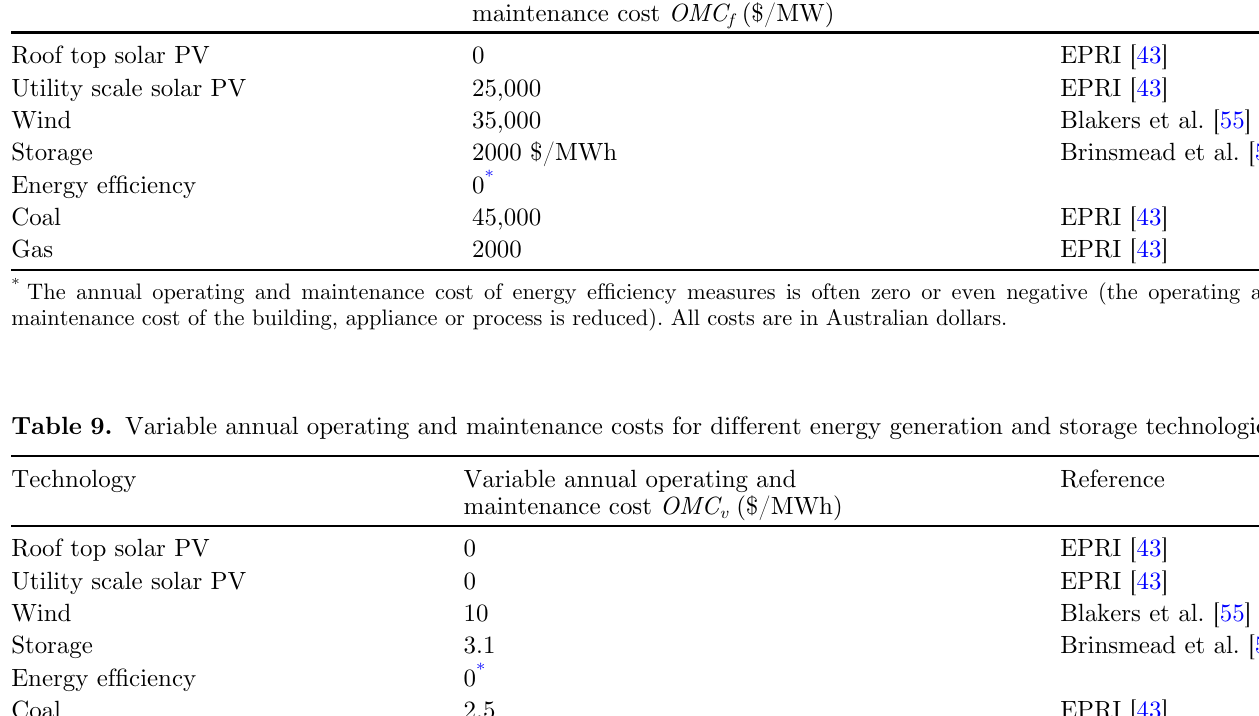
Table 8. Fixed annual operating and maintenance costs for different energy generation or storage technologies. Technology